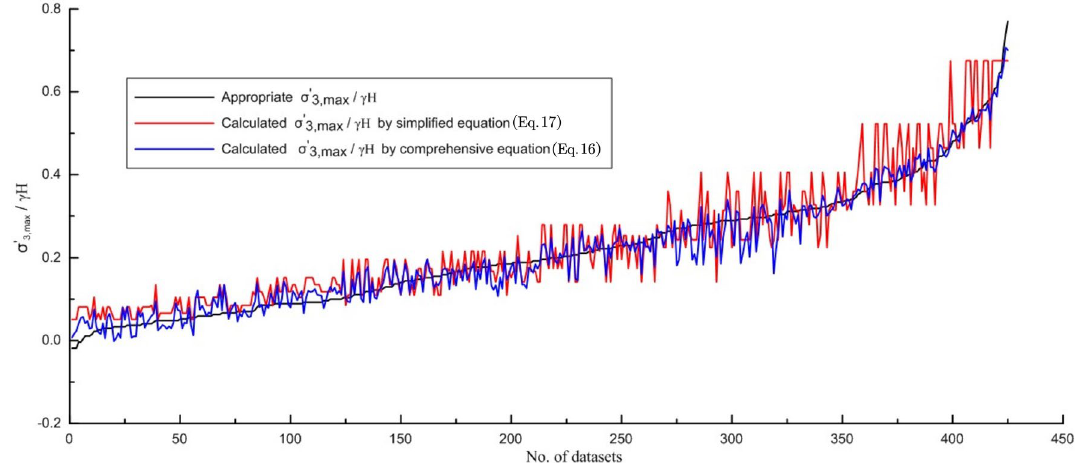
σ ′ 3,max Figure 10. Predicted γ H values from two quantitative